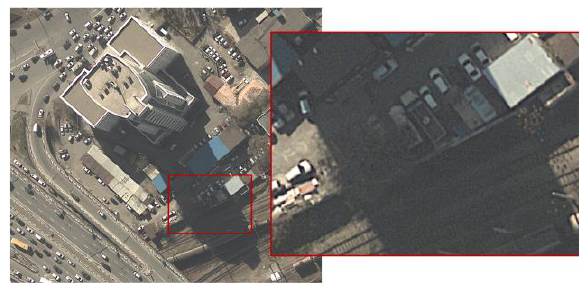
Figure 1. An example of losses in objects and their details, that fall into the shadow, due to the image random noise The causes of random image noise are both camera specifications, such as physical pixel size, matrix sensitivity, temperature, etc., and surveying settings, as the value of the exposure (Zotov,